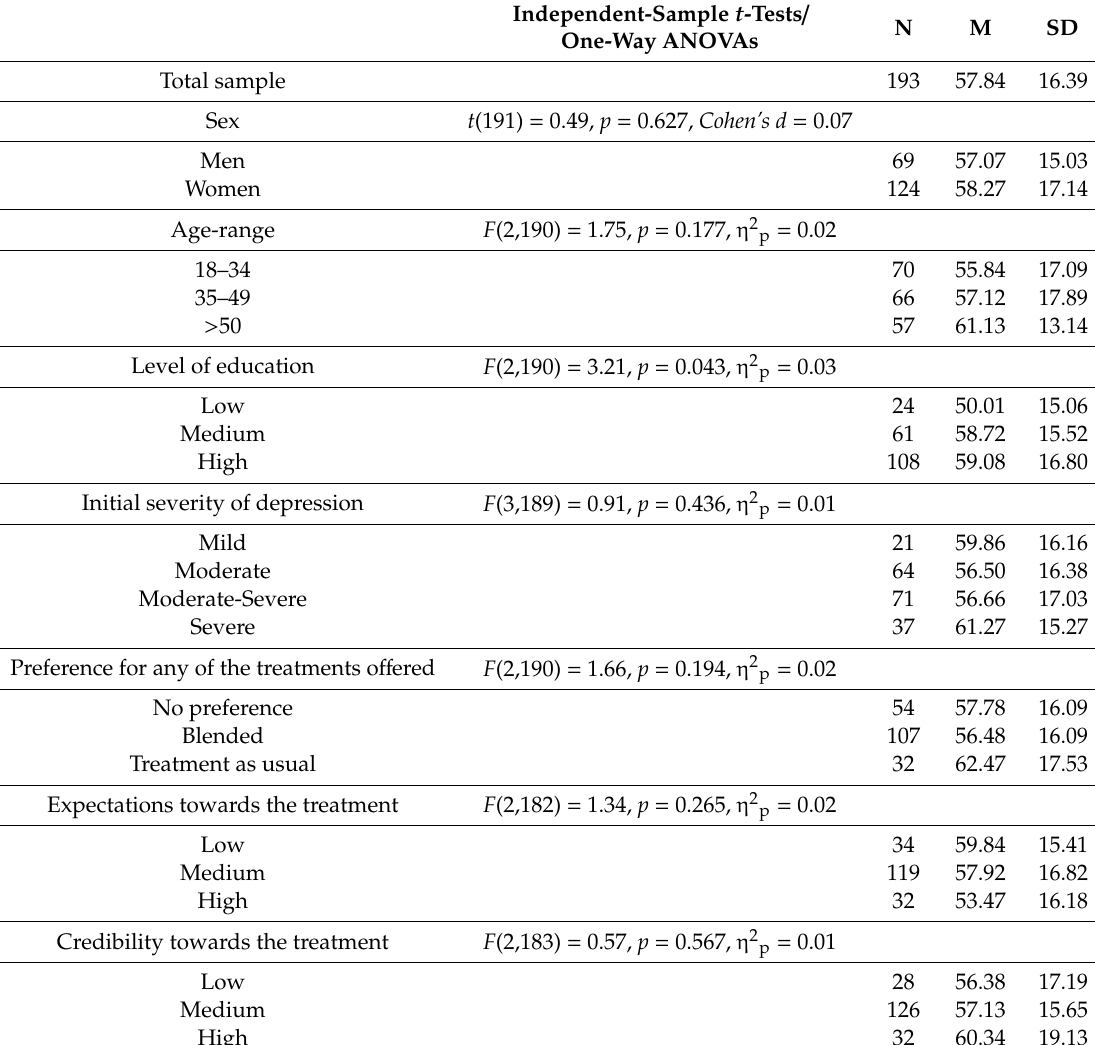
Table 3. Descriptive statistics of WAI-TECH scores in each